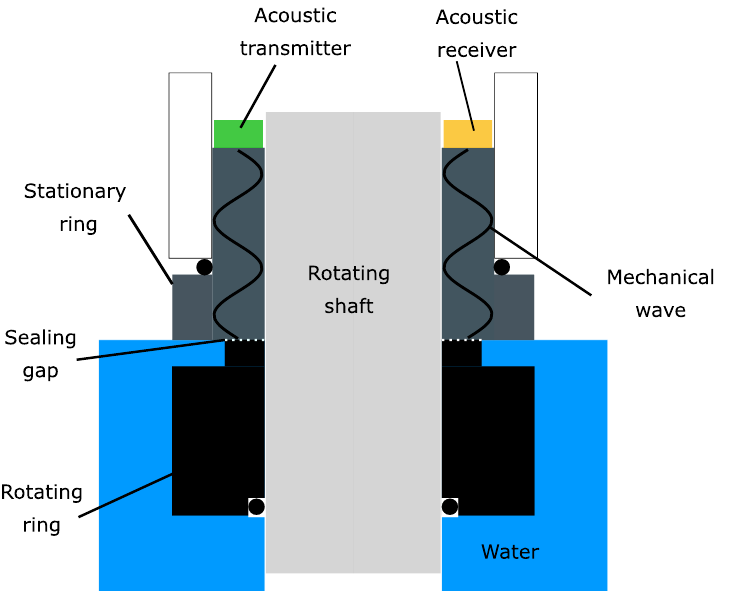
Figure 1. Schematic representation of a mechanical seal. The seal consists of a stationary ring and a rotating ring attached to the rotating shaft. The seal faces form the sealing gap. For mechanical monitoring purposes, an acoustic transmitter and a receiver are attached on the back side of the stationary ring. The acoustic transmitter incorporates a mechanical wave inside the stationary